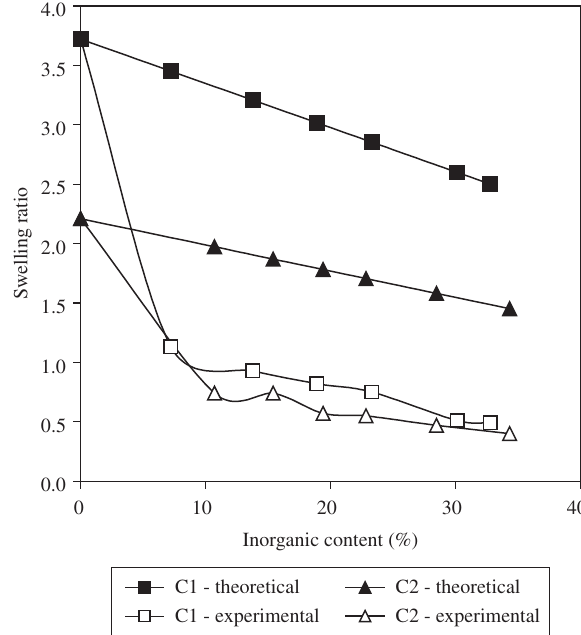
Figure 2. Photo of a C2-D sample. Figure 3. Effect of the incorporation of inorganic moieties on the swelling ratio of the modified